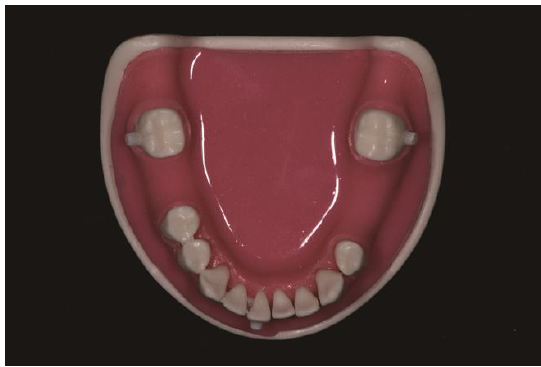
Figure 1. Mandibular typodont (CIBM01, Osstem, Busan, Korea) used in the present study. Ra- diopaque markers (Tetric N-Ceram, Ivoclar Vivadent, Schaan, Liechtenstein) were attached to the buccal surfaces of the bilateral second molars and the labial surface of the right central